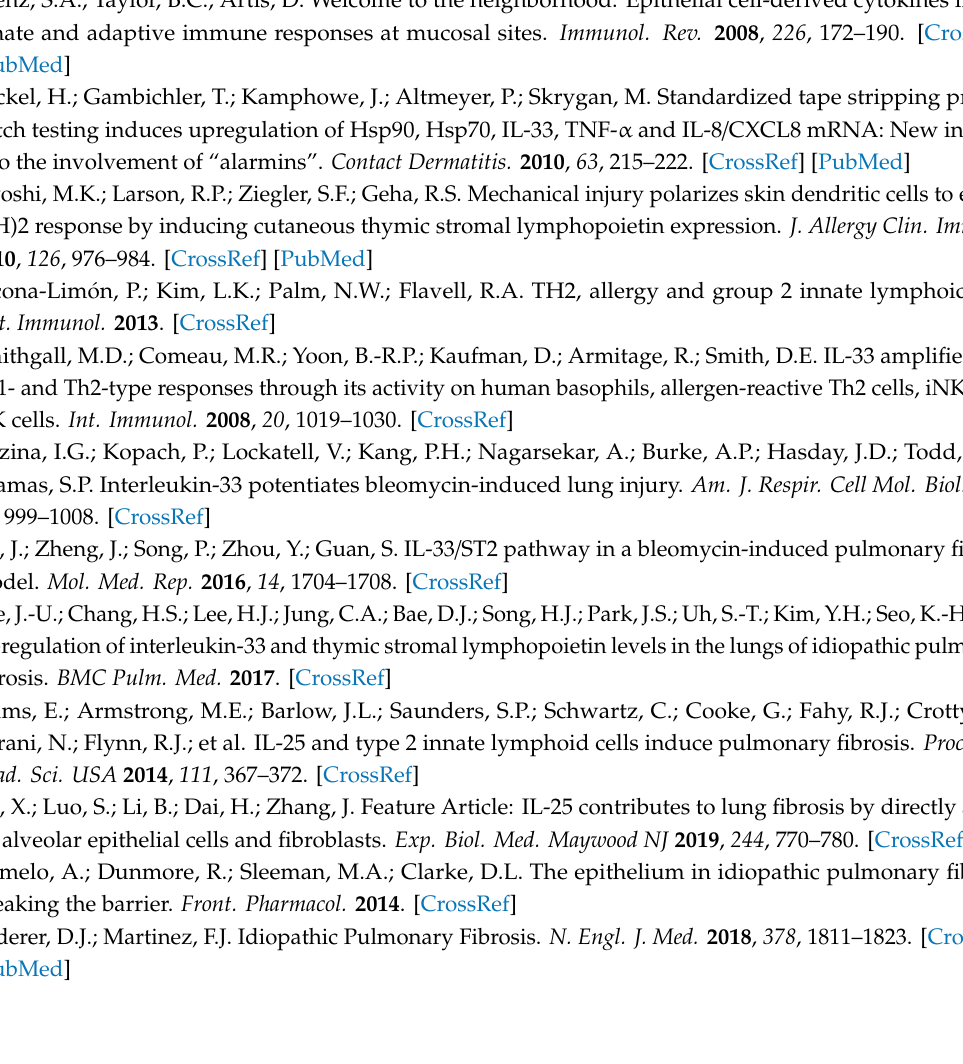
Figure S1. Changes in the epithelial alarmin levels in the serum of patients with IPF before and after 12 months of antifibrotic therapy; Figure S2. Changes in the epithelial alarmin levels in the serum of patients with IPF before and after 12 months of antifibrotic therapy according to the antifibrotic agent used; Figure S3. Changes in the epithelial alarmin levels in the serum of patients with IPF before and after 12 months of antifibrotic therapy according to the functional decline (stables—FVC % of predicted decline / year ≤ 5%; progressors—FVC % of predicted decline / year > 5%); Table S1. Correlations of the epithelial alarmin levels in the serum and EBC of patients with IPF; Table S2. Correlations between the epithelial alarmin levels and clinical measures in patients with